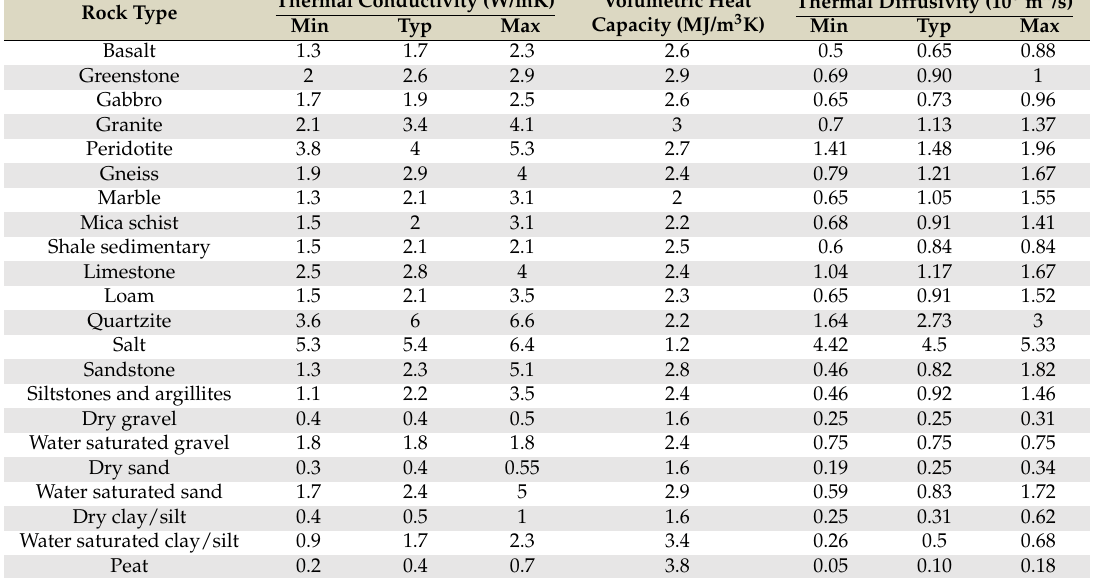
Table 1. Thermal conductivity, volumetric heat capacity and thermal diffusivity for different kinds of soil.